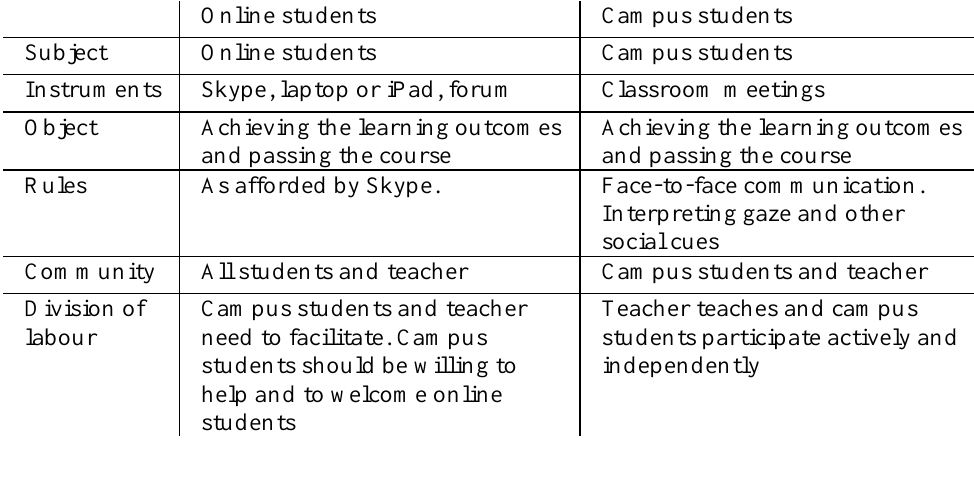
The Activity Systems of Online and Campus Students Online